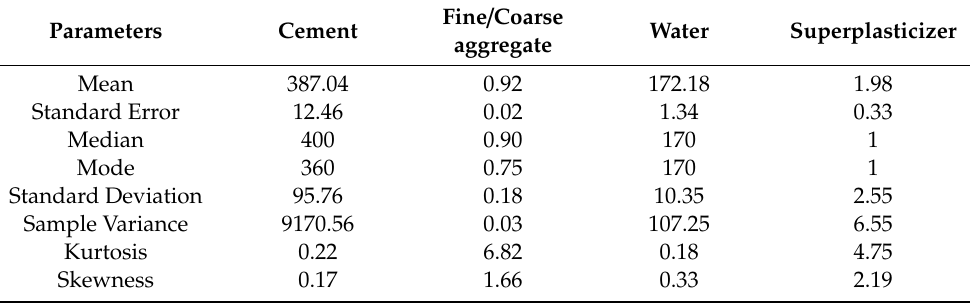
Table 4. Statistical description of testing data points used in the model (Kg / m 3